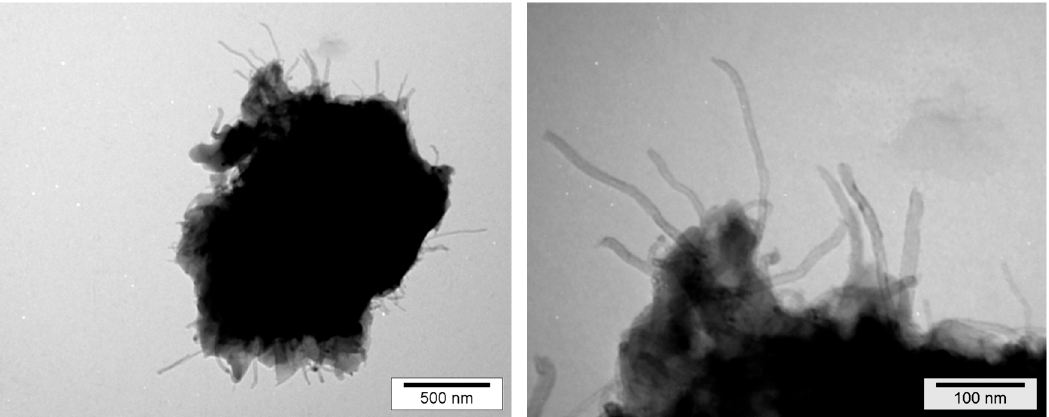
Figure 18. Released particle after wear of DGEBA/DDS/MWNT (0.7 wt %) nanocomposite with a bad dispersion, DD = 4.9.